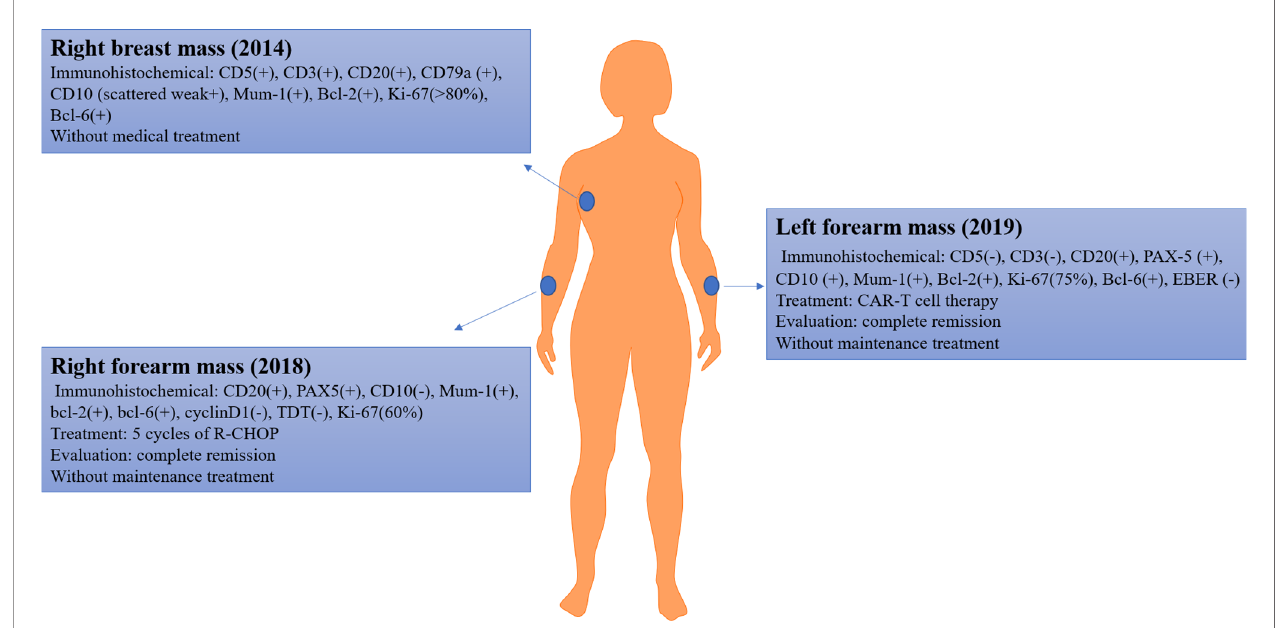
FIGURE 1 | The disease history of the patient. The blue circle indicates the